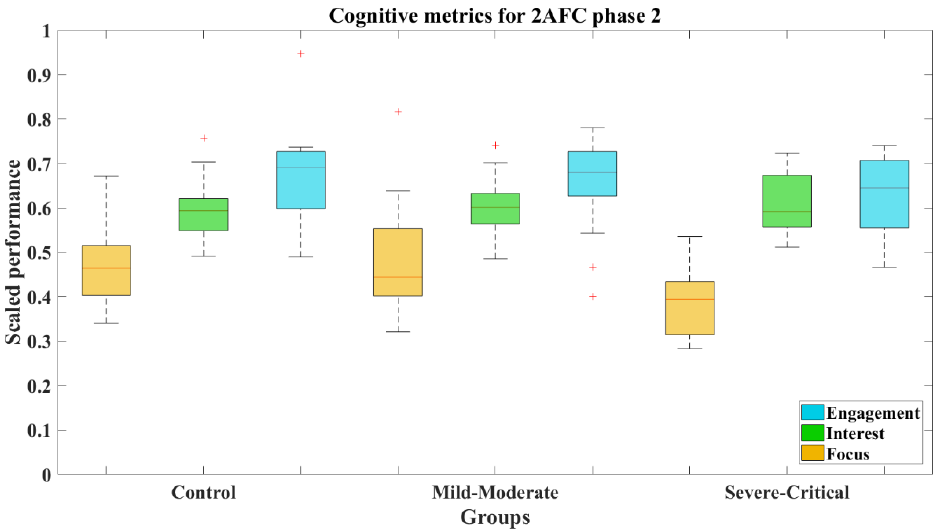
Figure 12. Cognitive metrics for 2AFC-P2 by group. Red line—median value of Focus, Interest, and Engagement for the corresponding group; red plus sign (+)—Outliers for the corresponding performance metric.